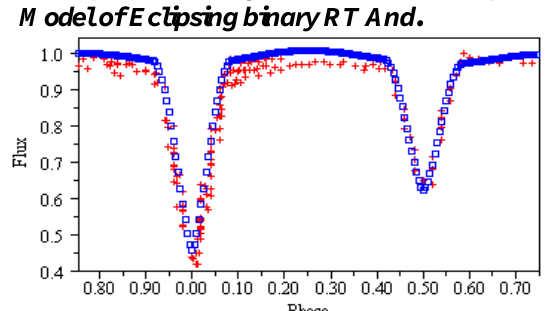
Fig.12: The synthetic light curve (square) and the experimental light curve (+) of spotted Model of Eclipsing binary BH